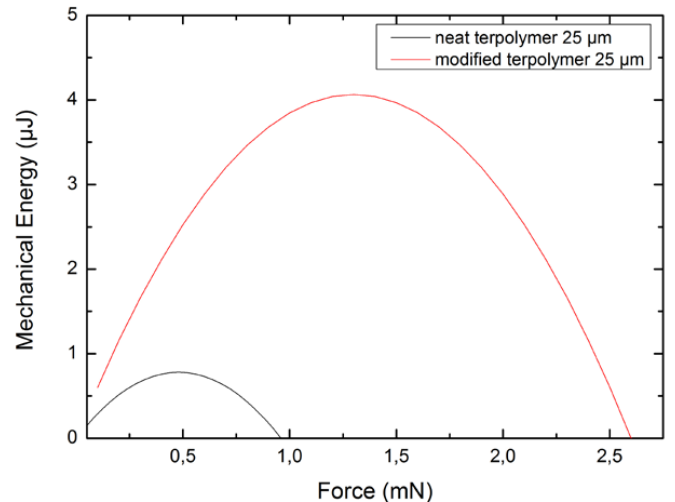
Figure 13. Mechanical energy density function of deflection for two compositions of terpolymer for an electric field of 40 V/μm.